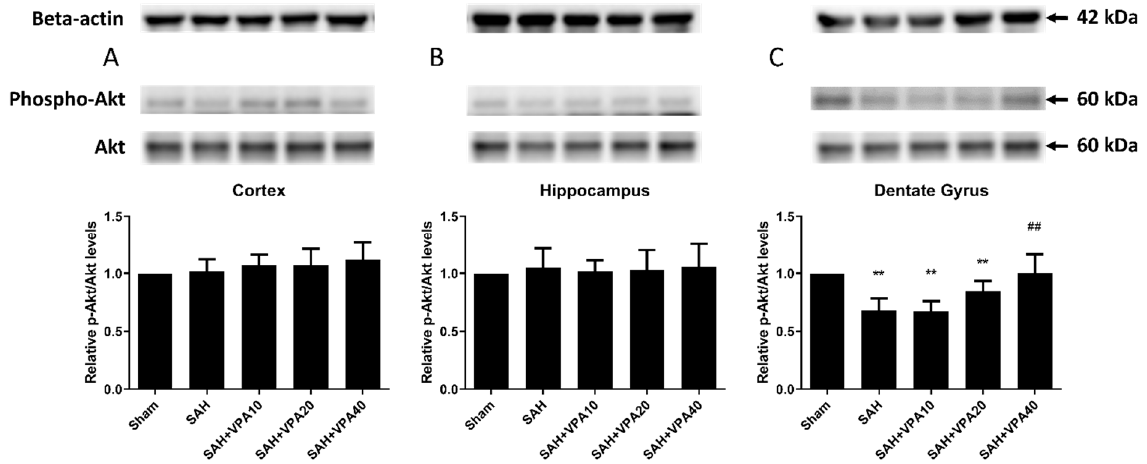
Figure 4. VPA upregulated Akt activation in dentate gyrus. ( A – C ) Top panel: representative expression of Akt and phospho-Akt protein. Beta-actin was used as control. Lower panel: quantification of relative p -Akt activity. All gels were run in the same experimental conditions ( n = 6). ** p < 0.01, compared with the sham group, ## p < 0.01, compared with the SAH group.